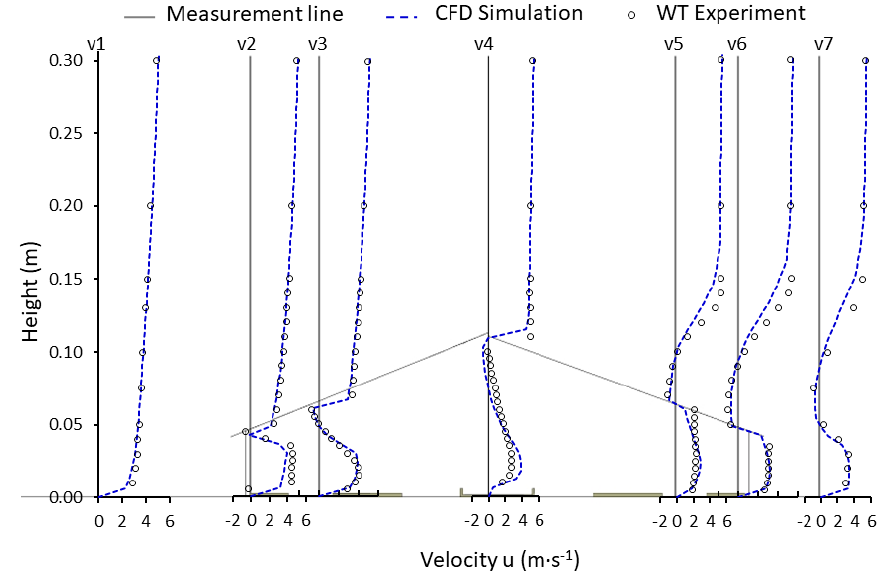
Figure 8. Comparison of stream-wise air velocity ( u ) profiles of BLWT measurement data with CFD simulation in different locations in and outside of the NVD barn for the completed opened sidewalls condition (Case 4 SWC). The inlet profile velocity at 0.1m height was 4.41 m · s − 1 . The zero velocity in x axis correspondence with the line of the measurement. Negative value of the velocity indicates opposite direction of airflow.